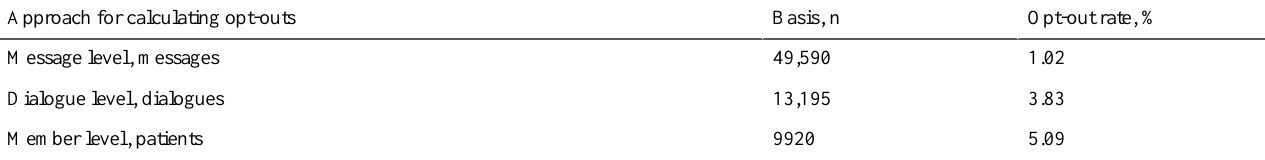
Table 5. Opt-out